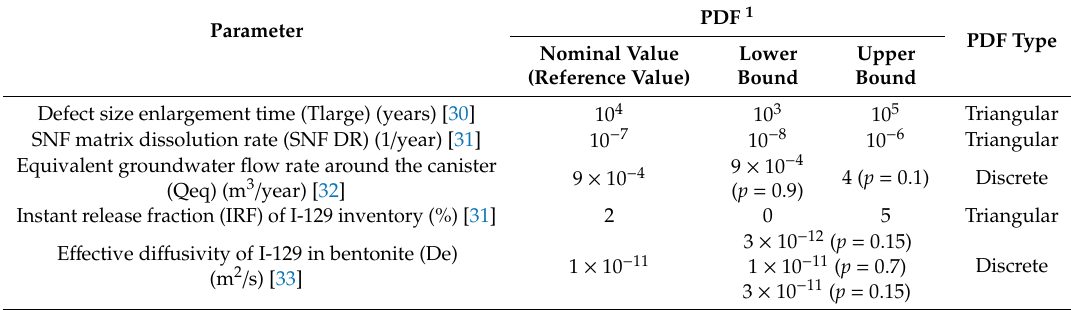
Table 1. Summary of input data for the radionuclide release modeling